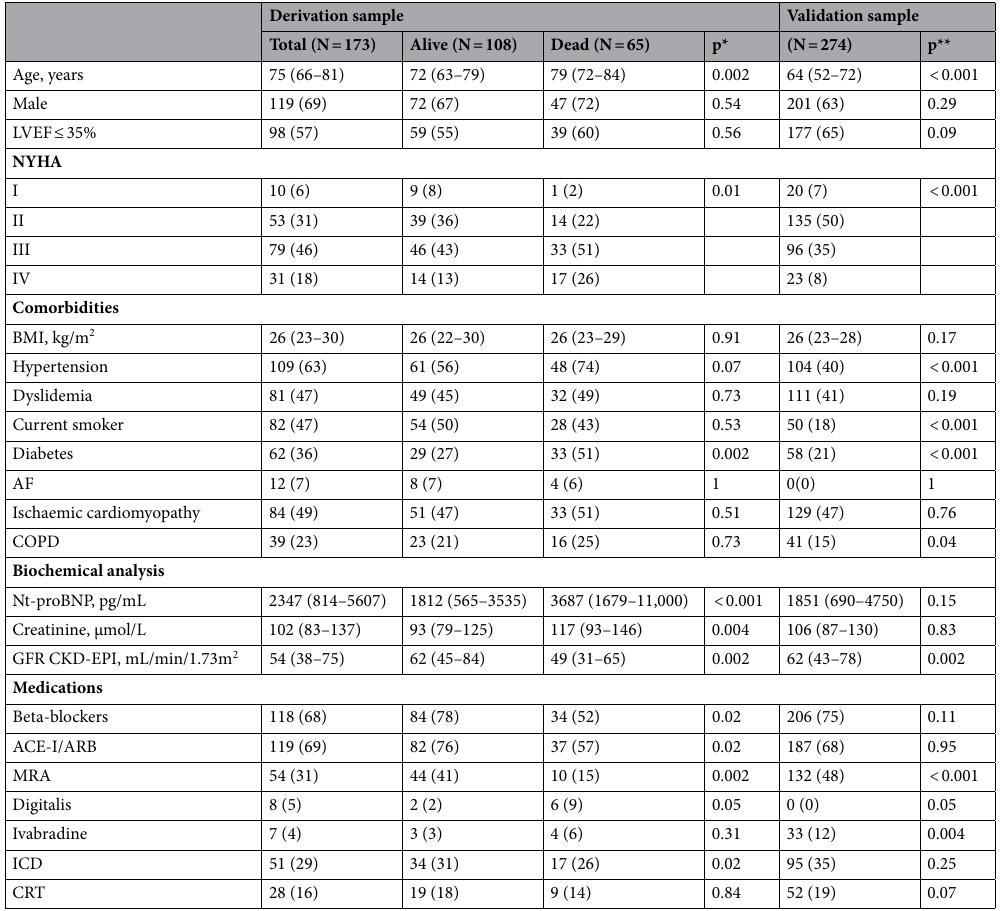
Table 1. Description of samples. Values are median (1st and 3rd quartiles) or N (%). ACE-I angiotensin converting enzyme inhibitor; AF atrial fibrillation; ARBs angiotensin receptor antagonist; BMI body mass index; CKD-EPI Chronic Kidney Disease Epidemiology Collaboration; COPD chronic obstructive pulmonary disease; LVEF left ventricular ejection fraction; GFR glomerular filtration rate; ICD implantable cardioverter- defibrillator; CRT cardiac resynchronization therapy; MRA Mineralocorticoid Receptor Antagonists; Nt-proBNP Nt-pro brain natriuretic peptide; NYHA New York Heart Association; p p-value. *Comparison of alive and dead patients from the derivation sample. **Comparison of the derivation and the validation sample.